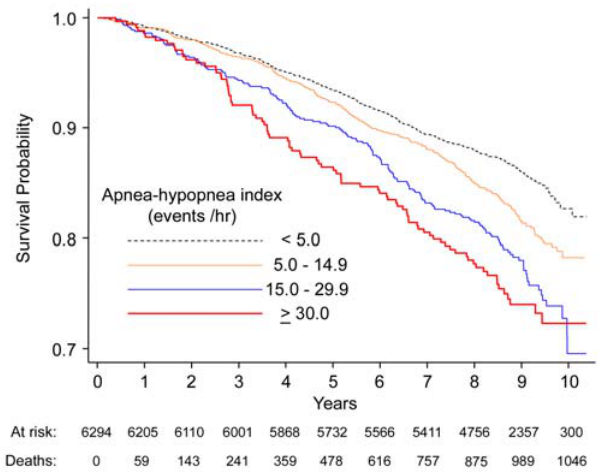
Figure 1. Kaplan-Meier survival curves across categories of the apnea–hypopnea index (AHI).